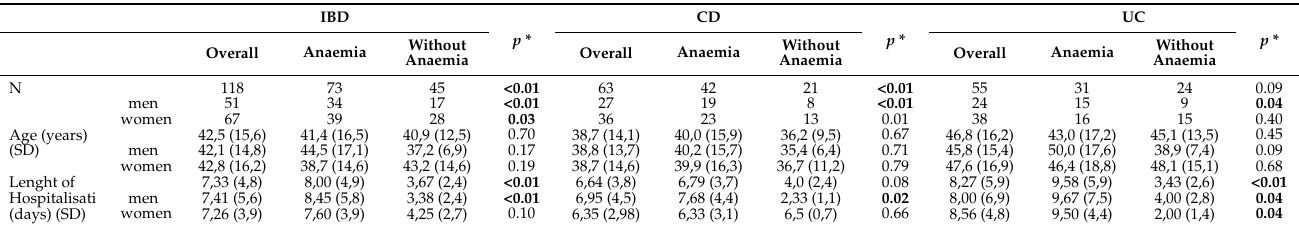
Table 1. Characteristics of the examined patients with